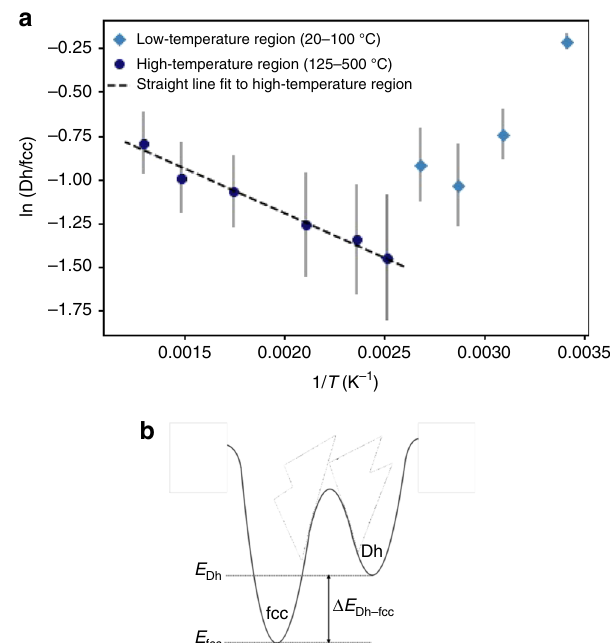
Fig. 3 The derived energy difference between fcc and Dh minima. a Ratio of the Dh to fcc abundances (natural log plot) for Au 561 plotted against the reciprocal of the temperature (in Kelvin). The dashed line shows a weighted least squares fi t to the high-temperature region. The equation of this line is: y = mx + c where m = − 510240 K and c = − 0.20 ± 0.40 in units of k Error bars, derived from data in Fig. 2 and using error propagation laws, are shown for the natural log of the Dh:fcc ratio. b A schematic of the derived energy difference between fcc and Dh